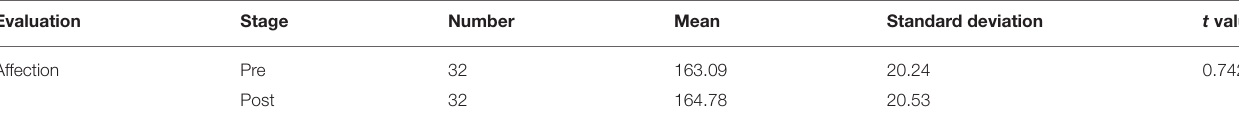
TABLE 6 | Pre-test and post-test t -test of affection effect of traditional physical education teaching.